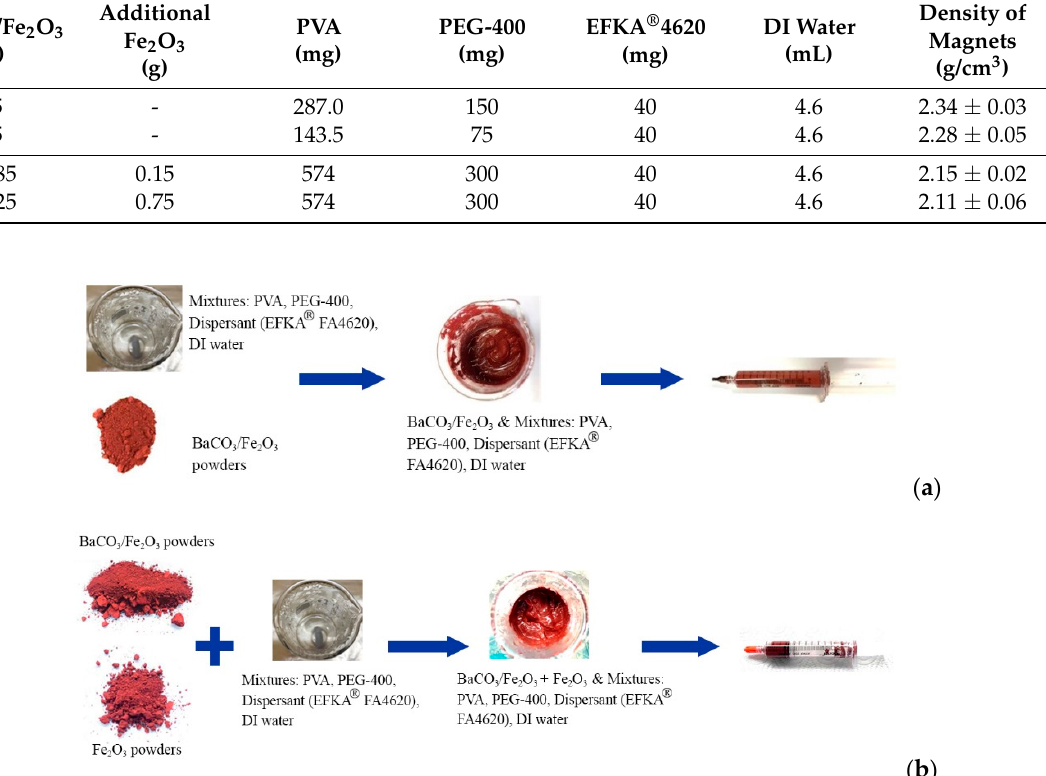
Table 1. Formulations of the ceramic–polymer pastes, and the density averaged from 3 samples of sintered hard/soft magnetic composites.